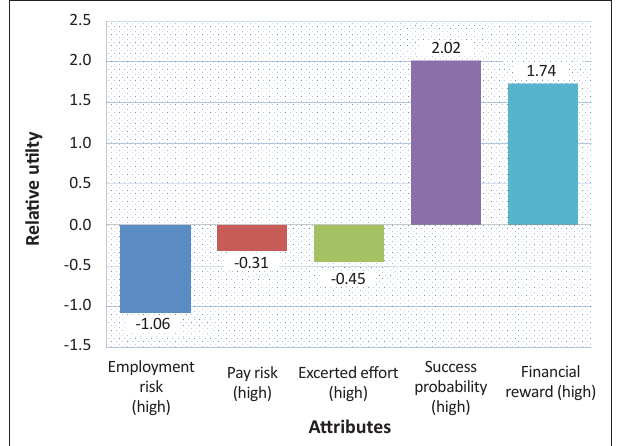
FIGURE 2: Part-worth utilities for each attribute.